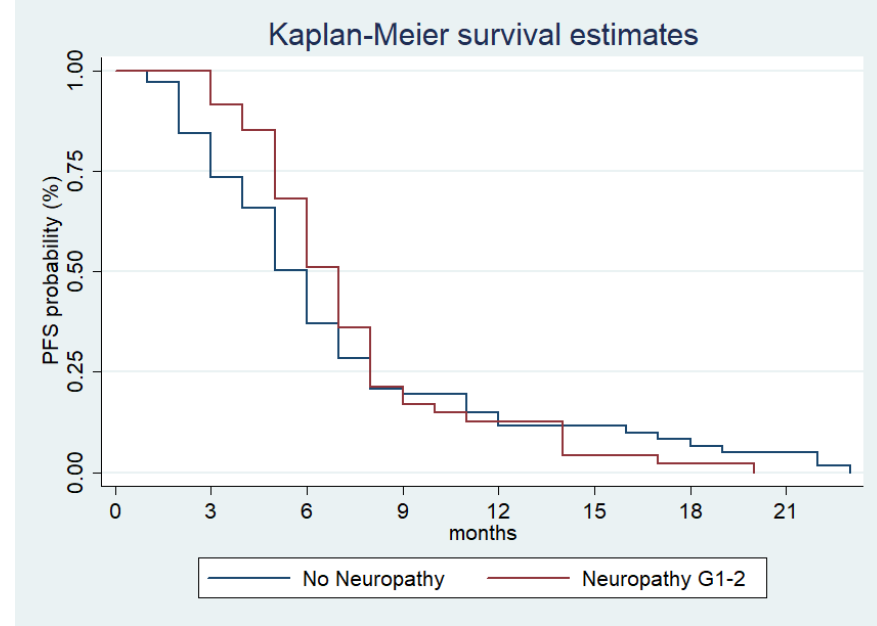
Figure 1. Estimated PFS for nab − Gem according to low-grade CIPN presentation. Meanwhile, OS was 13 months (95% CI (10–18 months)) and 10 months (95% CI (8–13 months)) in patients with and without neuropathy (Figure 2, p = 0.04).